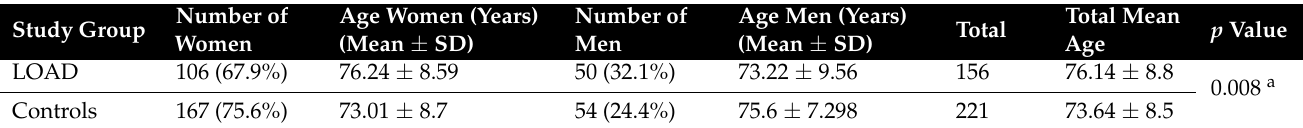
Table 1. Demographic characteristics of